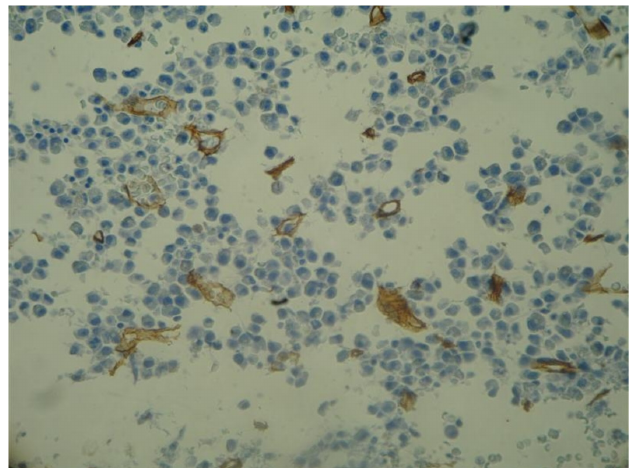
FIGURE 2B - Histological section of BMB stained immunohistochemically for CD34, 400 x magnification. Microvessels are stained in brown, clearly separated from one another, and either with or without a lumen. This sample was graded as degree IV